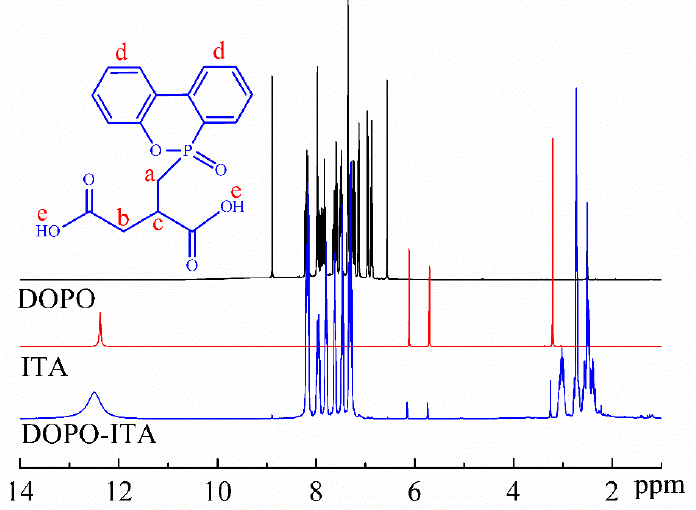
Figure 3. 1 H NMR spectra of DOPO-ITA.